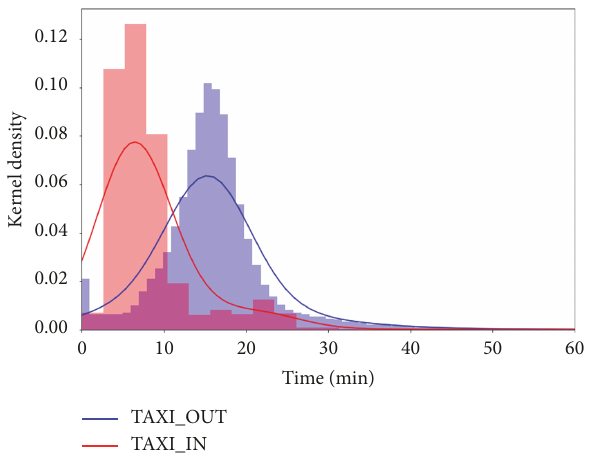
Figure 2: Taxi time in Nanjing Lukou International